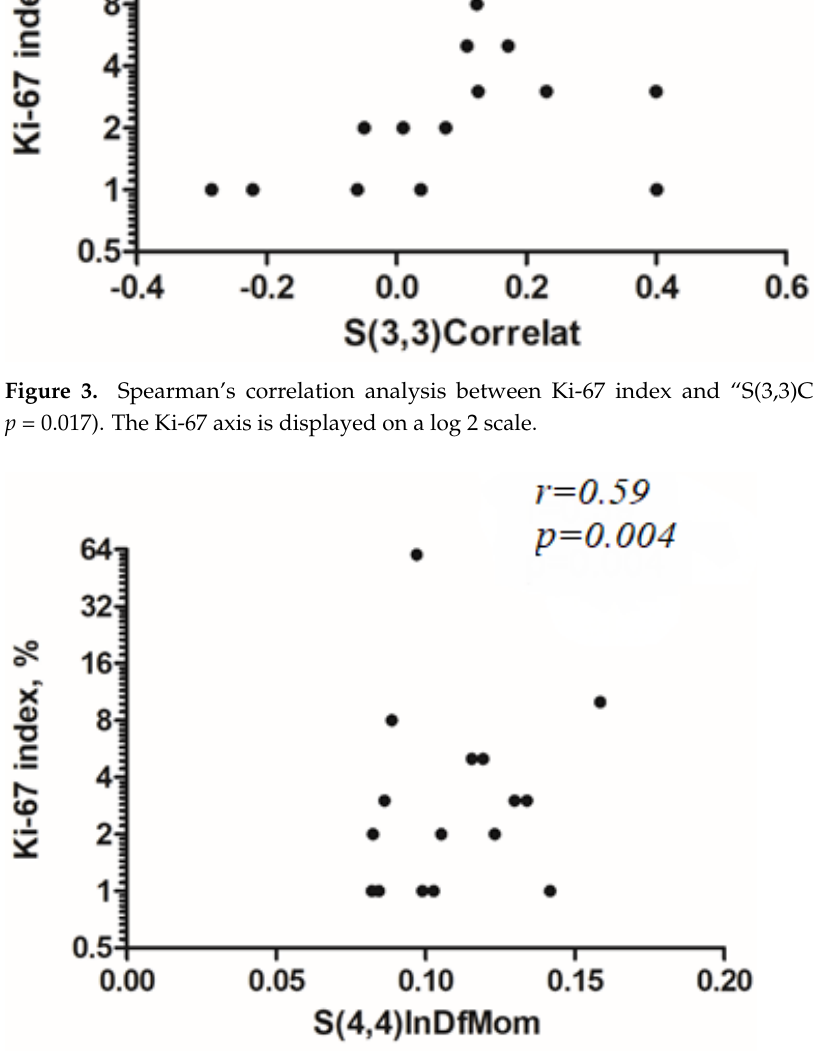
Figure 4. Spearman’s correlation analysis between Ki-67 index with “S(4,4)InvDfMom” ( r = 0.59, p = 0.004). The Ki-67 axis is displayed on a log 2 scale.